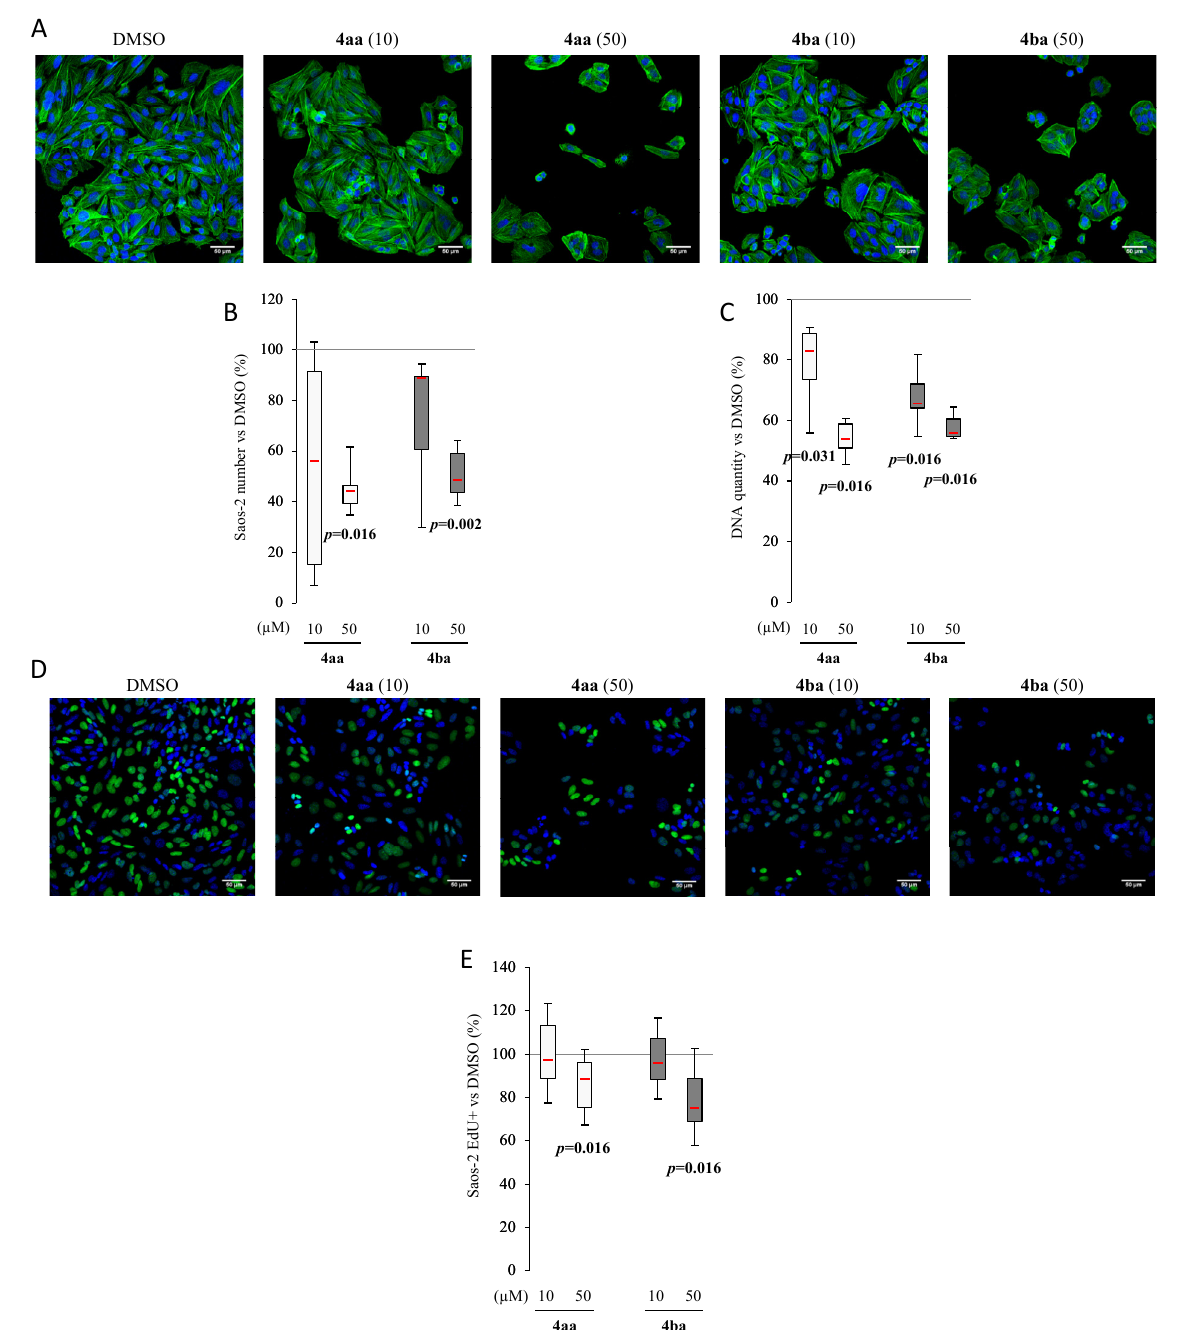
Figure 3. Pyridazinone scaffold-based molecules decrease Saos-2 proliferation. Representative confocal images of cell morphology using confocal LSM 710 NLO Zeiss. Cytoskeleton was stained with Phalloidin/Alexafluor TM 488 (green) and nuclei with DAPI (blue) ( A ). Scale bar = 50 µm. Saos-2 number variation versus DMSO with cell count per field ( B ) and DNA quantification ( C ). Representative confocal images of cell proliferation with EdU stained (green) and nuclei stained with DAPI (blue) ( D ). Scale bar = 50 µm. Number of EdU positive cells quantification versus DMSO ( E ). n = 7, min 8 cells per field, randomly chosen, 5 fields per condition. p -values are given relative to DMSO on box-plots.